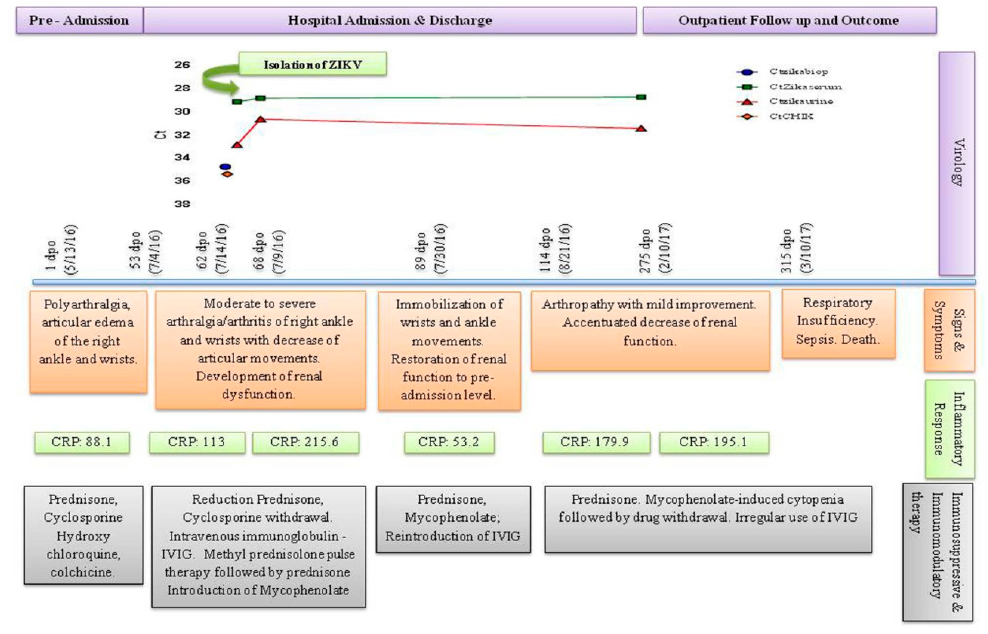
Figure 1. Timeline of virological kinetic, clinical features, inflammatory response and immunosuppressive/immunomodulatory therapy. Persistence of ZIKV RNA occurred in parallel with progressive clinical deterioration and increased inflammatory response during drug-induced immunosuppression. ZIKV replication was demonstrated in the first serum sample. Cycle threshold: Ct; reactive, if Ct < 38 and not reactive, >38. * Not reactive; DPO: Days post symptom onset; Reference values: CPR–0.0–5.0 mg/dL.